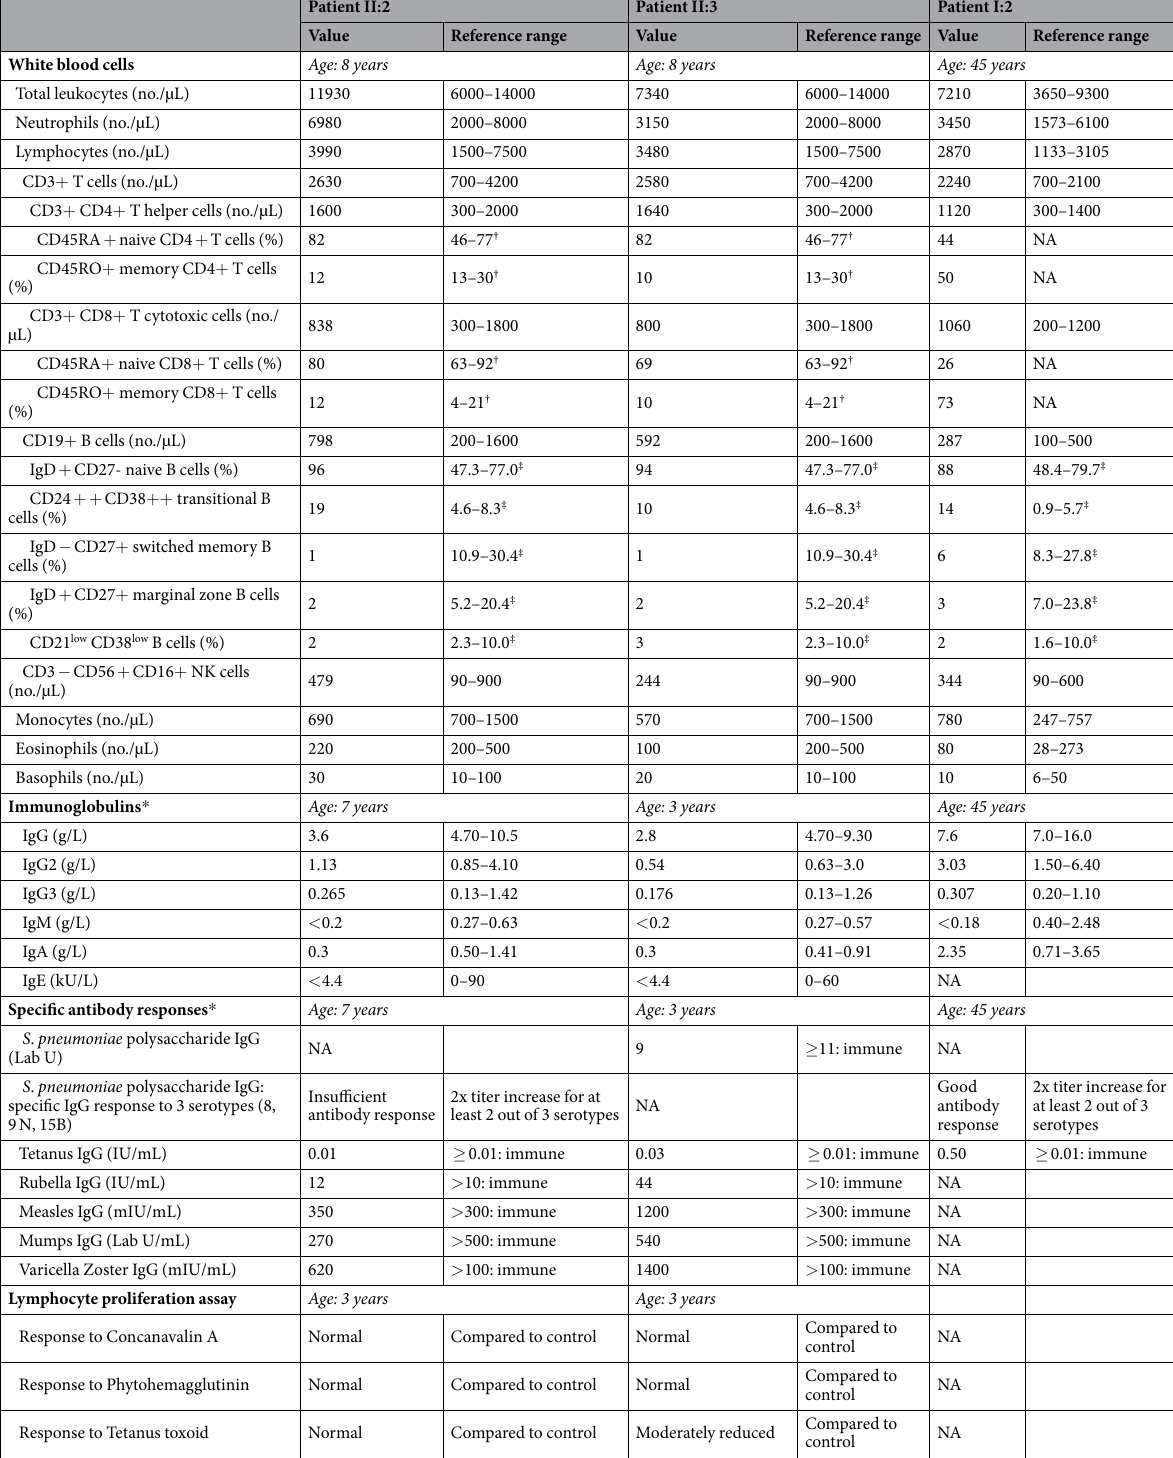
Table 1. Routine immunological laboratory results of the family A patients with Wiedemann-Steiner syndrome. The most recent, comprehensive and representative laboratory results are shown for each patient. Patients II:2 and II:3 were immunized according to the recommended Belgian childhood immunization schedule that, among others, included tetanus, measles, mumps, rubella and 7-valent conjugated pneumococcal vaccines. Patient